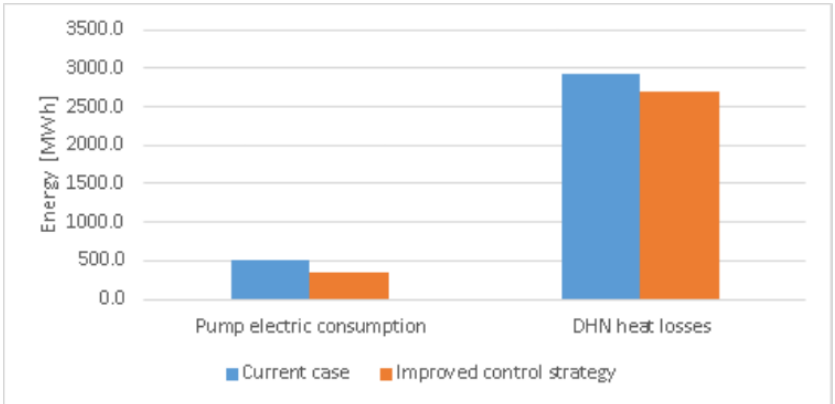
Figure 7. Pump electric consumption and DHN heat losses of the case study and improved control